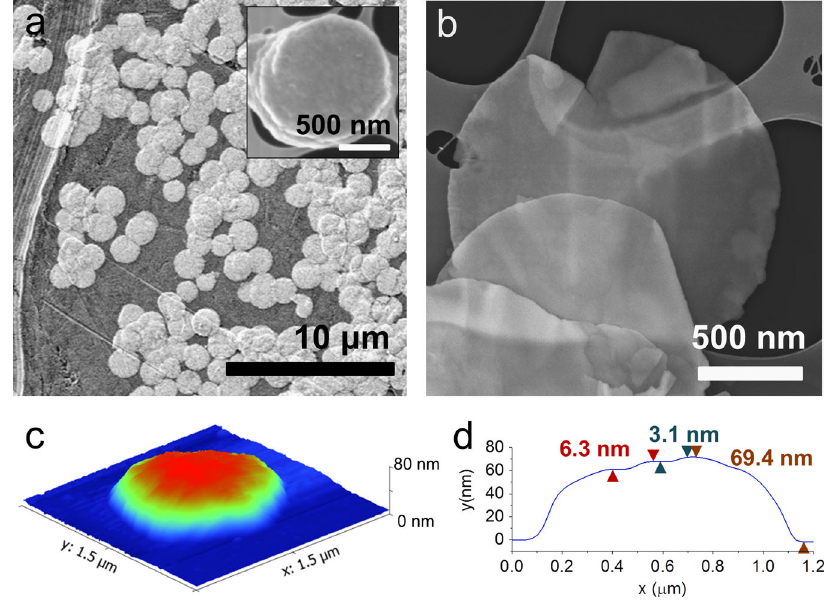
Fig. 1 SEM images of platelet-like particles on top of a substrate ( a ) and on top of a TEM grid ( b ) and inset in a . AFM 3D image of a single platelet ( c ). The thickness pro fi le at the centre of the platelet is displayed in d : the measured thickness is 69.4 nm and several steps are observed on top, the smallest measured step has a value of 3.1